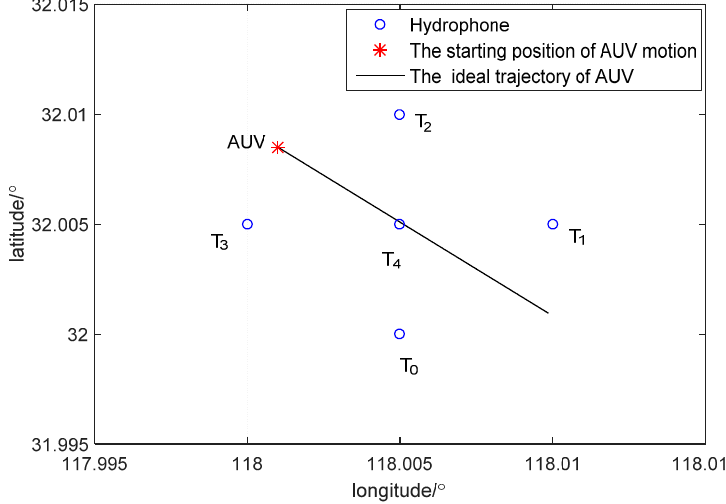
Figure 8. Hydrophone layout and initial position of AUV.